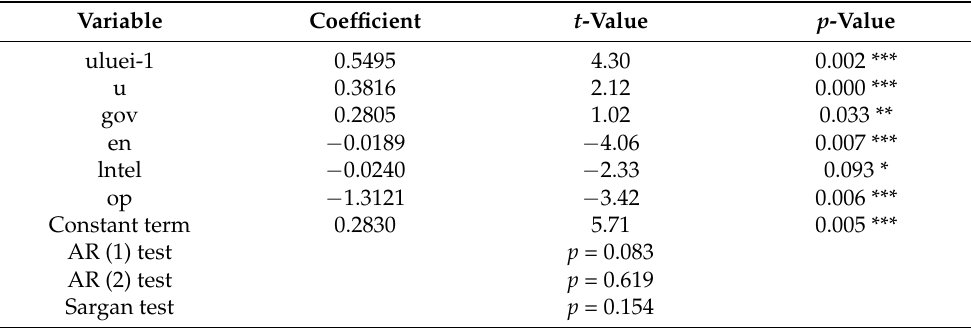
Table 5. Regression results of model